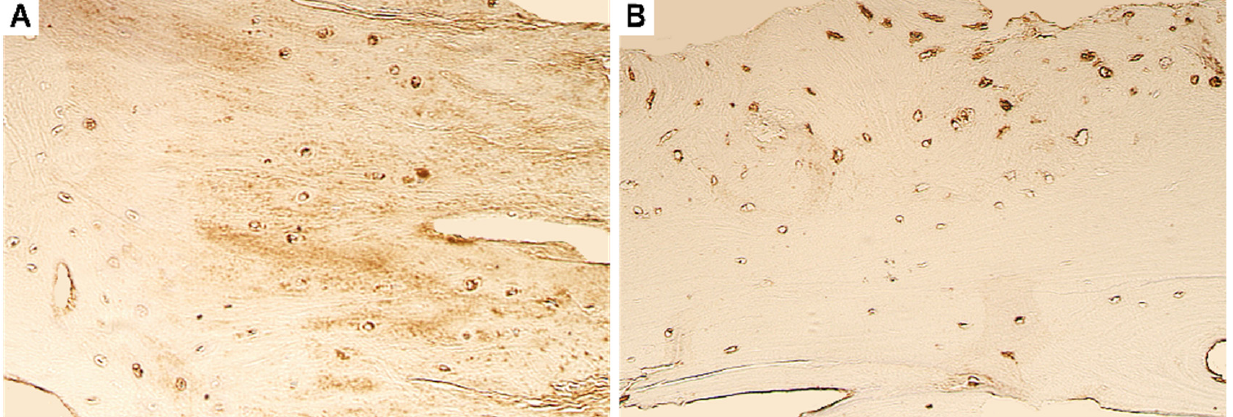
Figure 5. Microphotographs of the fibrous cartilage obtained during the ( A ) primary surgery and ( B ) repeated surgery. Note the presence of moderate number of BD-2-positive cells in the tissue material. Original magnification, 250×.